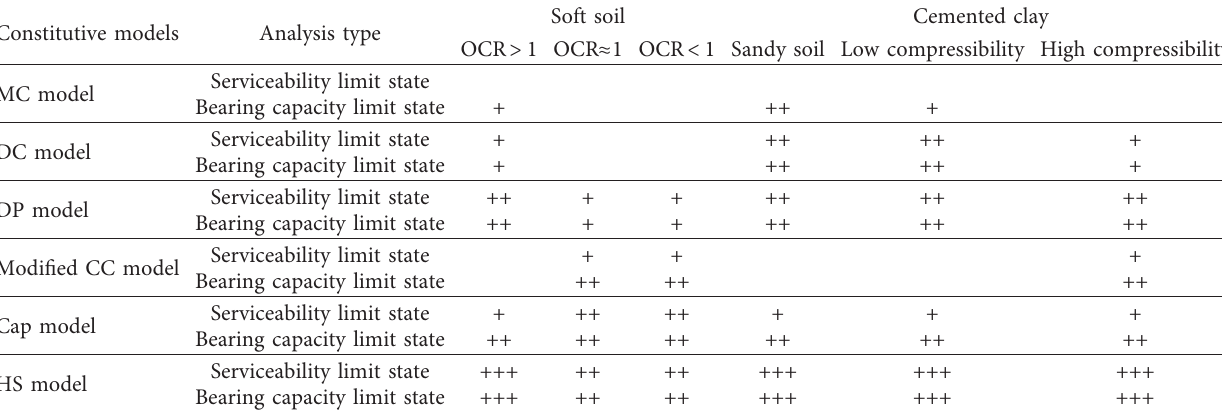
Table 1: The applicable conditions for different constitutive models of cemented clay and soft soil. Constitutive